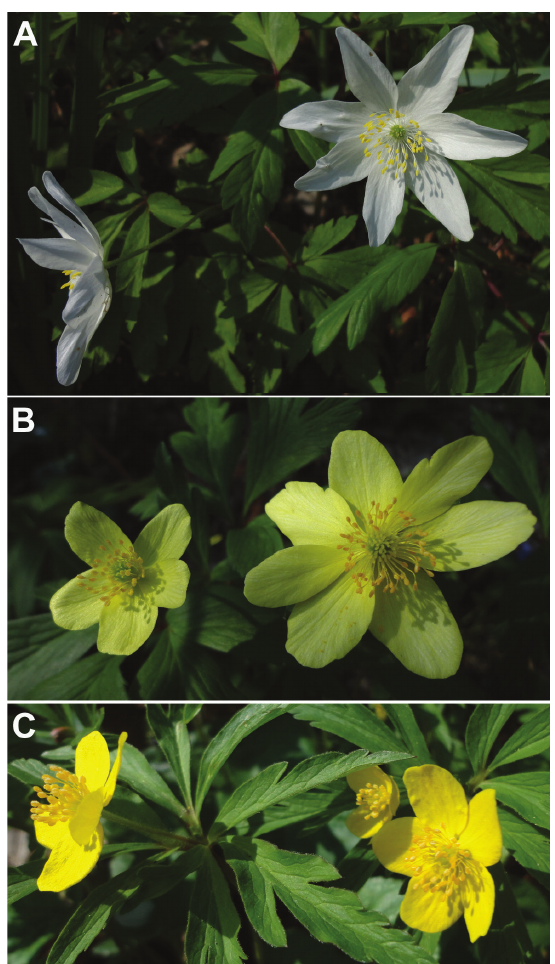
Figure 1. Anemonoides nemorosa (L.) Holub ( A ), A. ranunculoides (L.) Holub ( C ) and their putative hybrid ( B ) from Via di Roncrio, Bologna, N Italy. March 2017. Photo by L.